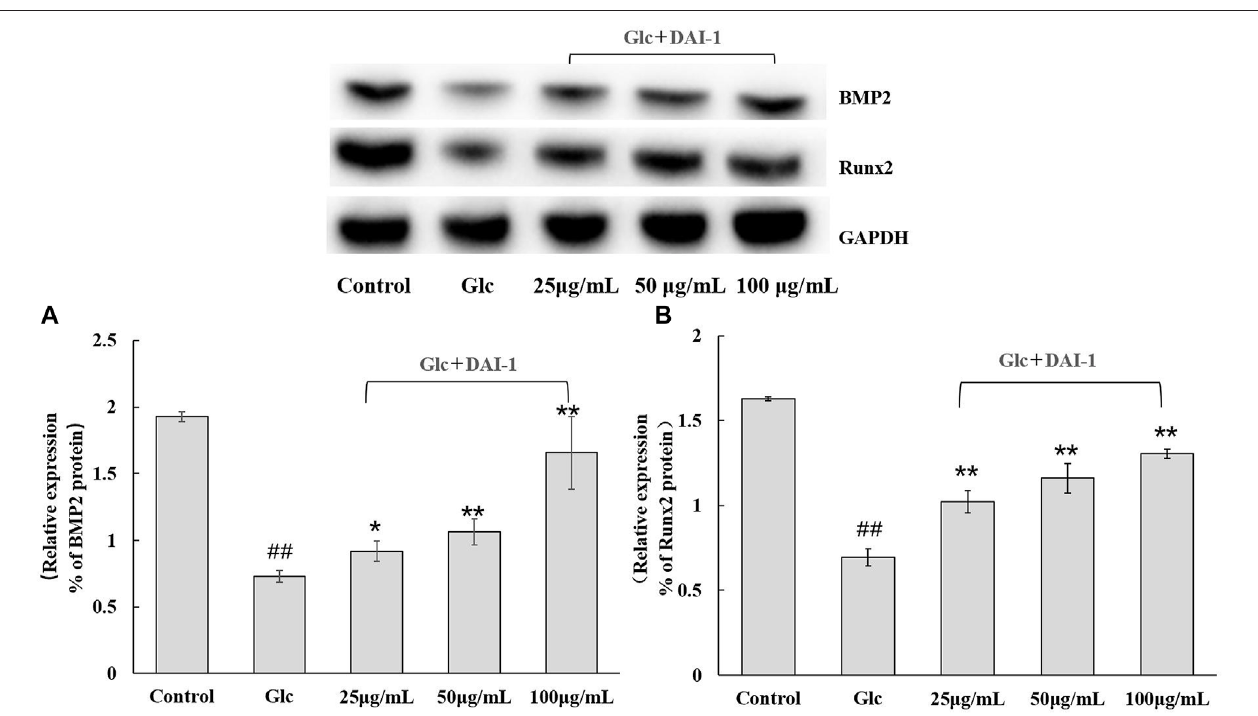
FIGURE 5 | The effect of DAI-1 on the relative protein expression of the osteoblast differentiation-related factors BMP-2 (A) and Runx2 (B) in a high-glucose environment. After 48 h of treatment, the protein levels of BMP-2 and Runx2 in osteoblasts were quanti fi ed by western blot. GAPDH served as a loading control. ## : p < 0.01, for high-glucose group vs . the control group; *: p < 0.05, **: p < 0.01, for the DAI-1and DAI-2 treated group vs . high-glucose